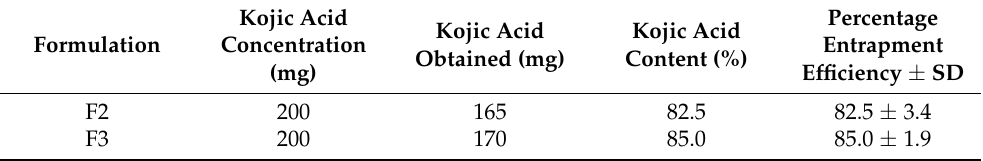
Table 3. KA content and encapsulation efficiency.